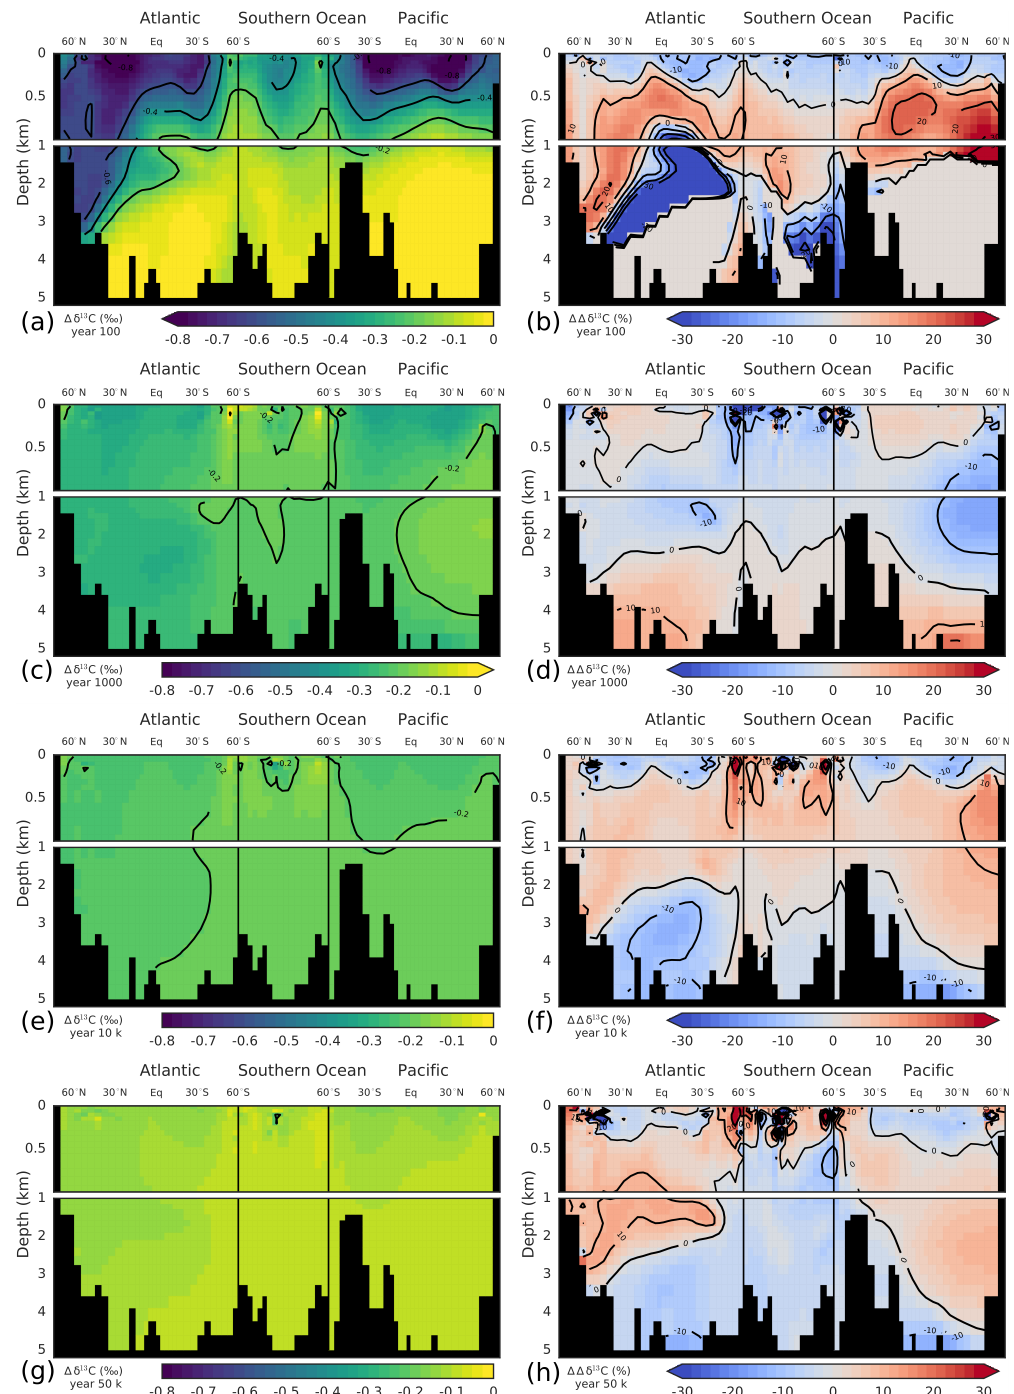
Figure 6. Modeled δ 13 C DIC perturbations (‰) (a, c, e, g) and difference between modeled and reconstructed δ 13 C DIC perturbation using the first three principal components. These differences are shown in percent of the modeled perturbation (b, d, f, h) . Shown are time slices at 100 years (a, b) , 1kyr (c, d) , 10kyr (e, f) , and 50kyr (g, h) after the pulse release of carbon. Note that in panel (b) perturbation values smaller than | 0 . 05 | ‰ (abyssal Atlantic and Pacific) were masked for better visibility as the perturbation has not yet propagated into these regions (see panel a